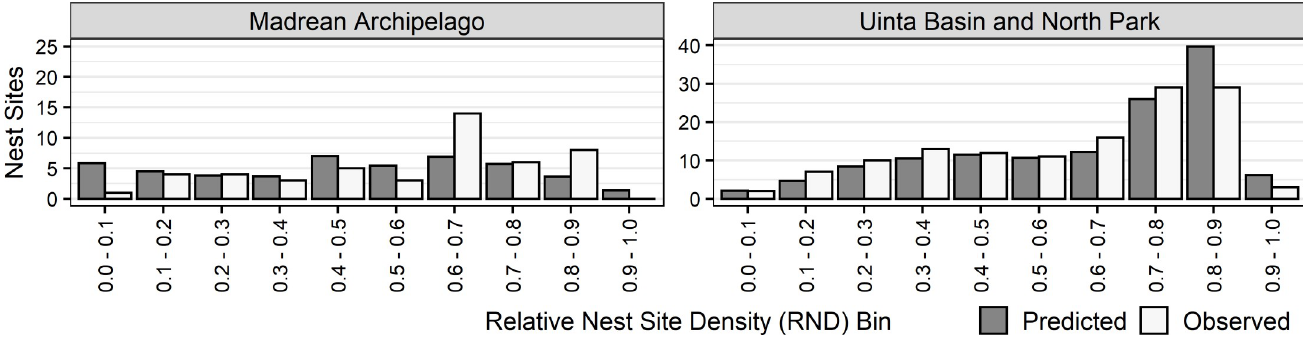
Fig 5. Bar plots of the distribution of predicted and observed nest sites among RND bins in the Madrean Archipelago, and Uinta Basin and North Park.